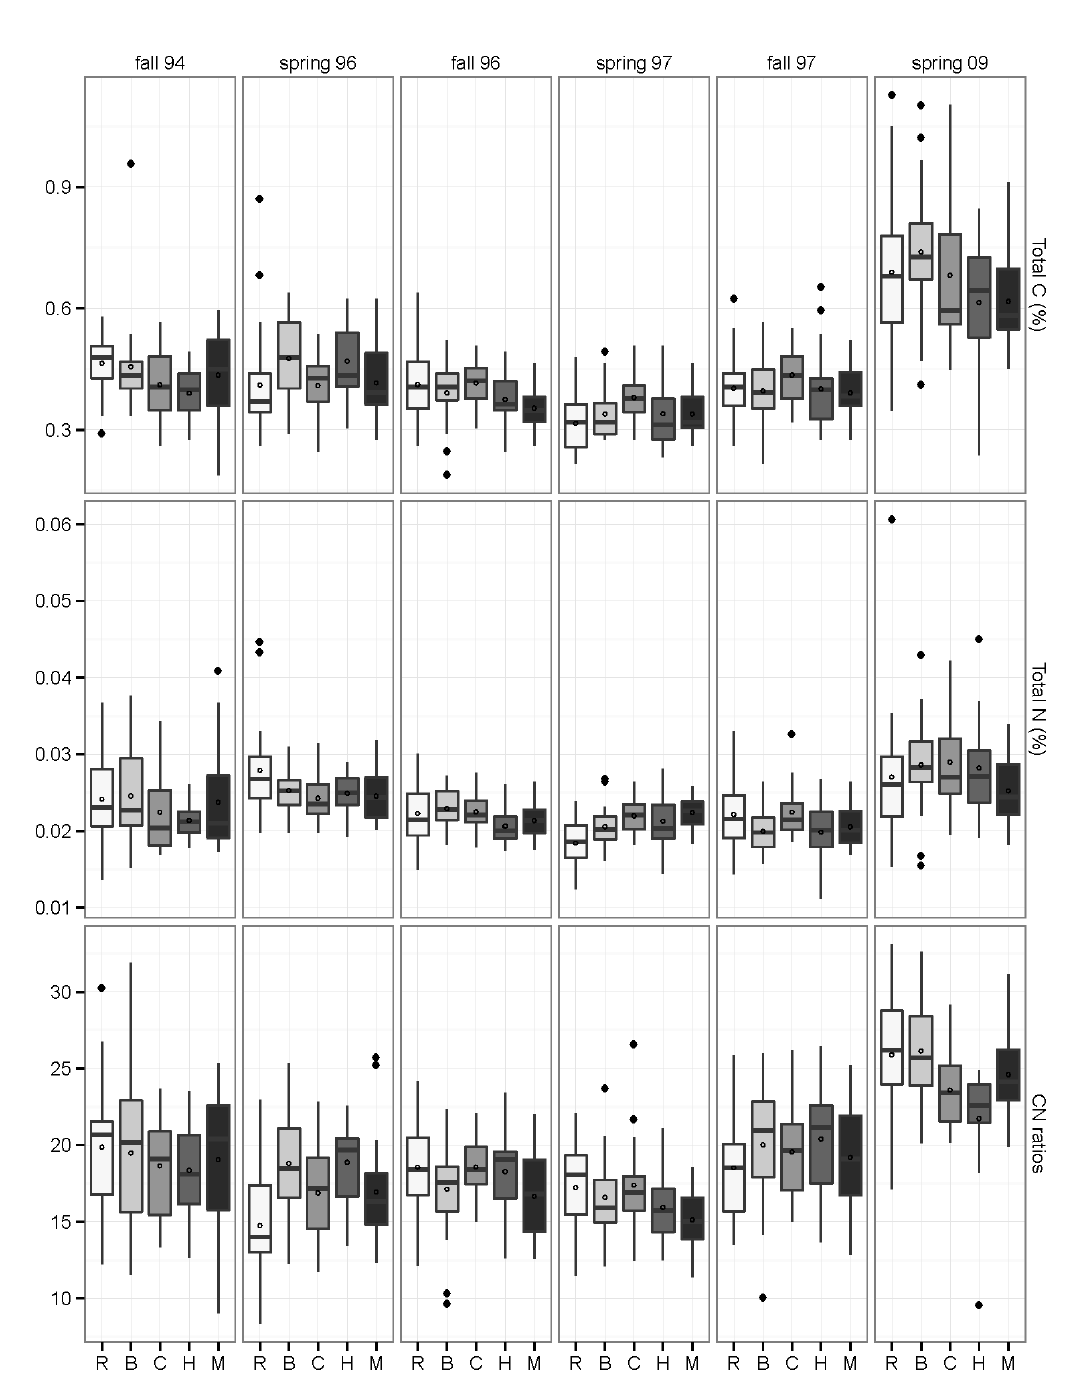
Figure 1. Box plots of soil total C (%), total N (%), and CN ratios for longleaf pine forests at Eglin Air Force Base, Florida. The boundary of the box plot closest to zero indicates the 25th percentile, the line within the box marks the median, the open circle indicates the mean, and the boundary of the box plot farthest from zero indicates the 75th percentile. Error bars above and below indicate the 90th and 10th percentile. Means (open circles) for treatments (Reference not included in the GLMM analysis) with the same letter do not differ at p < 0.05. R = reference; B = burn-only; C = delayed burn; H = herbicide; M =